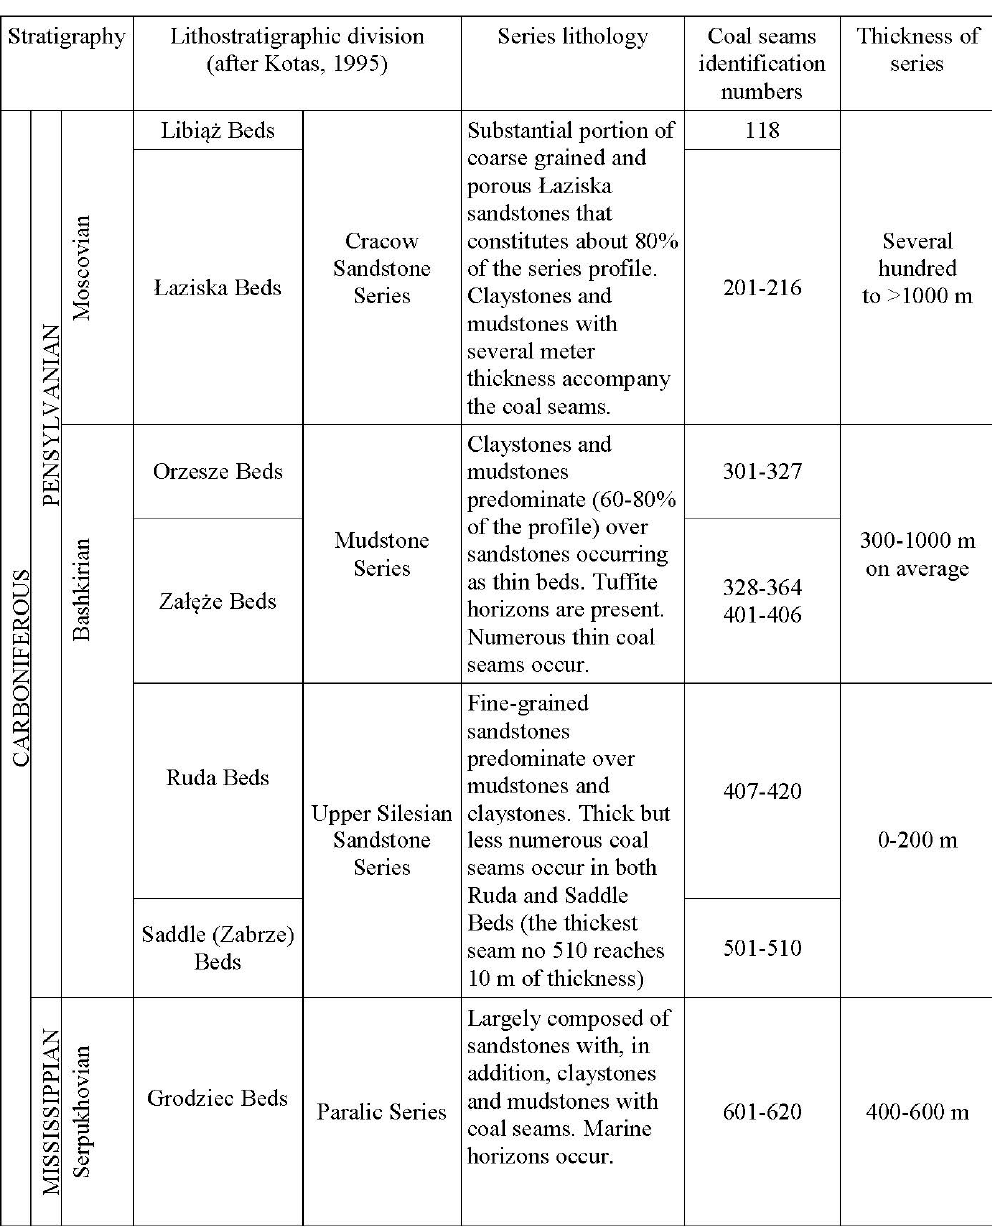
Figure 2. Stratigraphy of the coal-bearing series after [7,26].